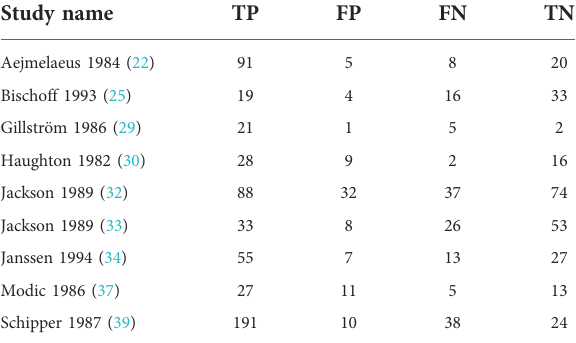
TABLE 4 Characteristics of myelography diagnostic tests.